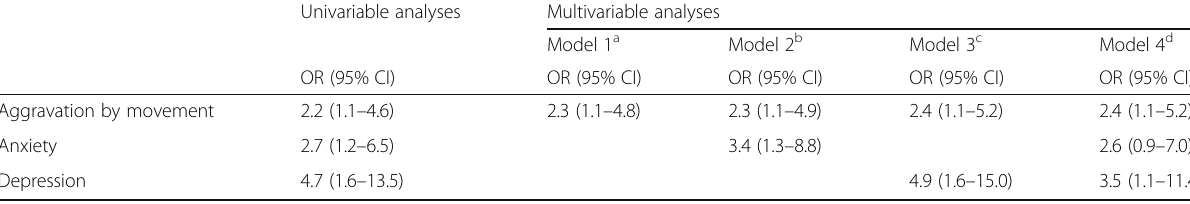
Table 3 Univariate and multivariable logistic regression analyses of RLS among individuals with tension-type headache ( N = 570) Univariable